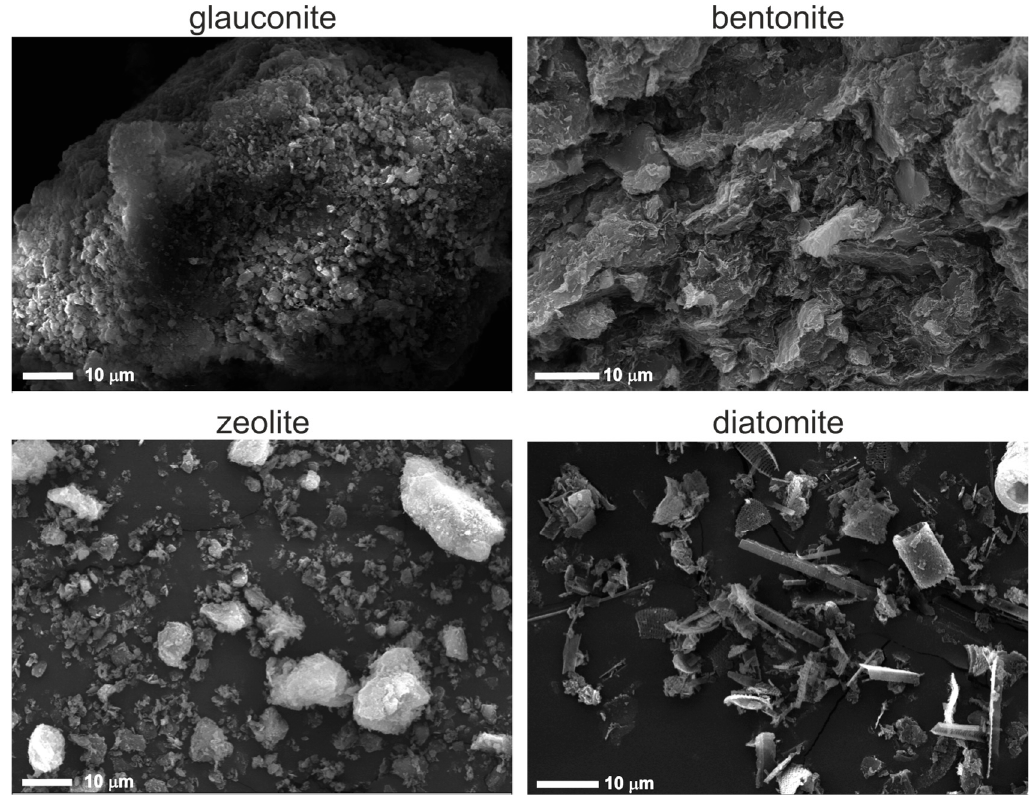
Figure 3. Scanning electron microscope images .